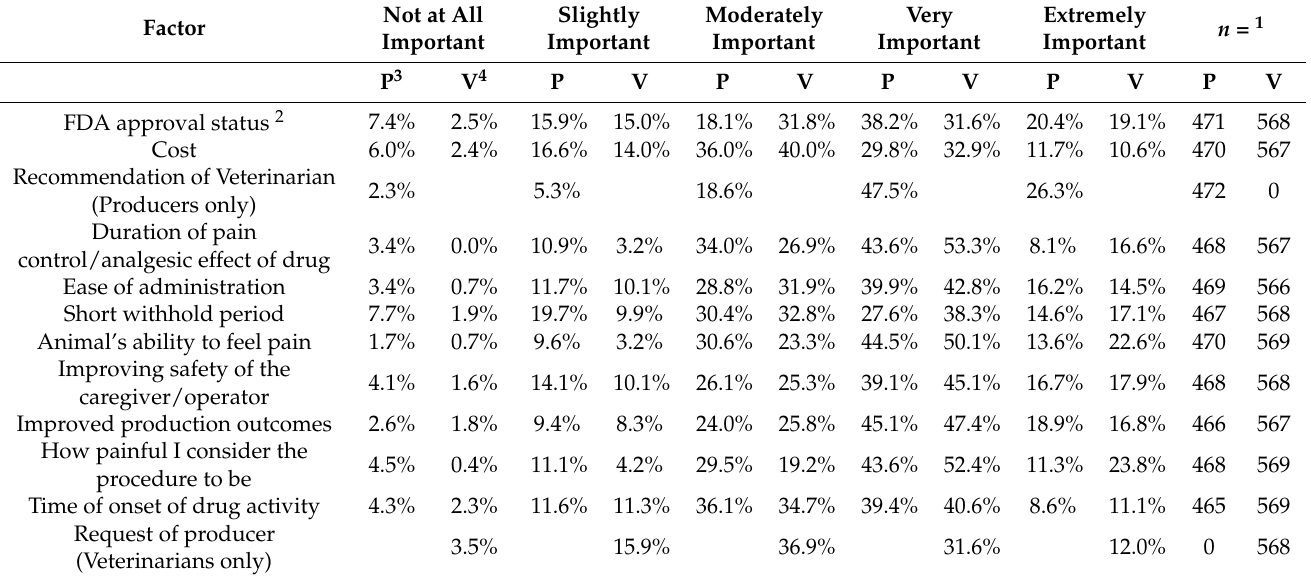
Table 5. Survey respondent factors ( n = 1066) impacting the decision to use analgesics drug in adult cattle and calves based on